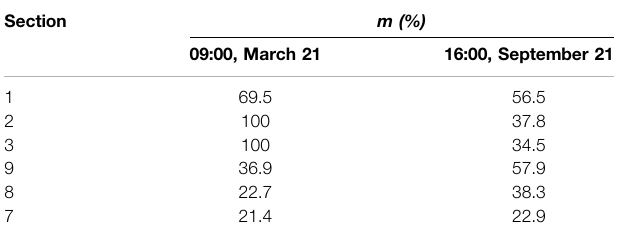
TABLE 4 | Values for the valve aperture at each section for the two additional scenarios analyzed. Section